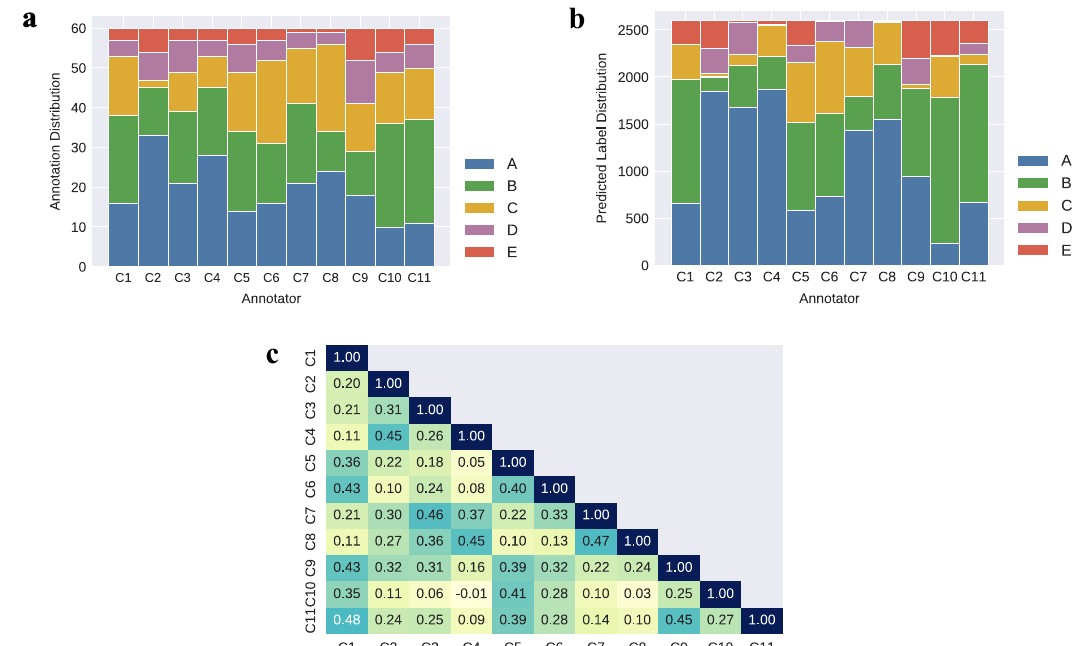
Fig. 3 Distributions of the 11 consultants ’ annotations on the training dataset and predicted labels on the external validation dataset. a Annotation distributions across all consultants ’ (C1-C11) labelled QEUH training datasets. b Predicted label distributions across the consultants ’ RF multiclass models, run on the HiRID validation dataset. c Pairwise Cohen ’ s κ values across all consultant pairs for the predicted labels made by the multiclass RF models on the external HiRID validation